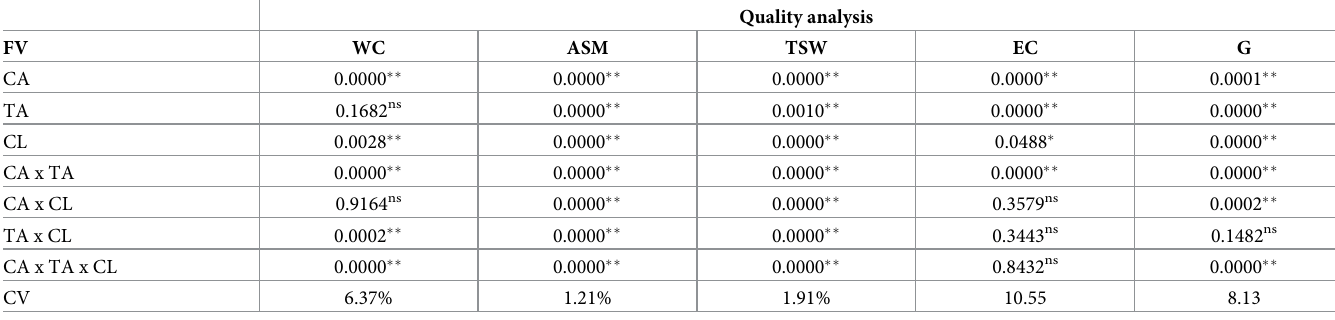
Table 5. Analysis of variance for physical and physiological quality of soybean